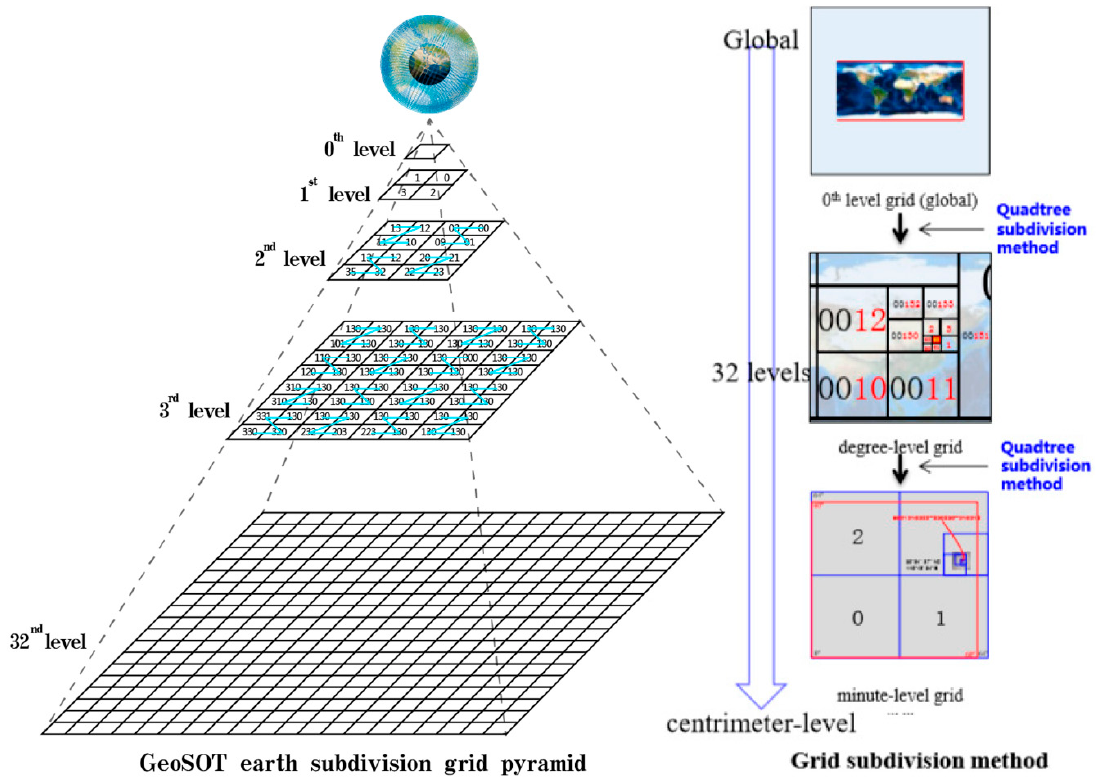
Figure 3. Sketch showing the hierarchy of the Earth’s subdivision patches.